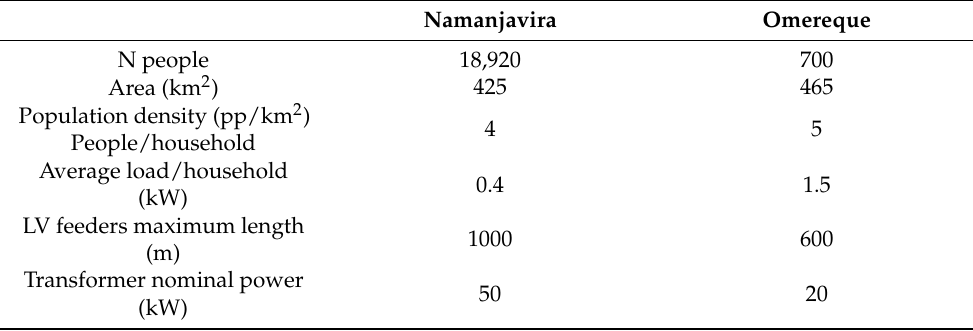
Table 1. Parameters of the case